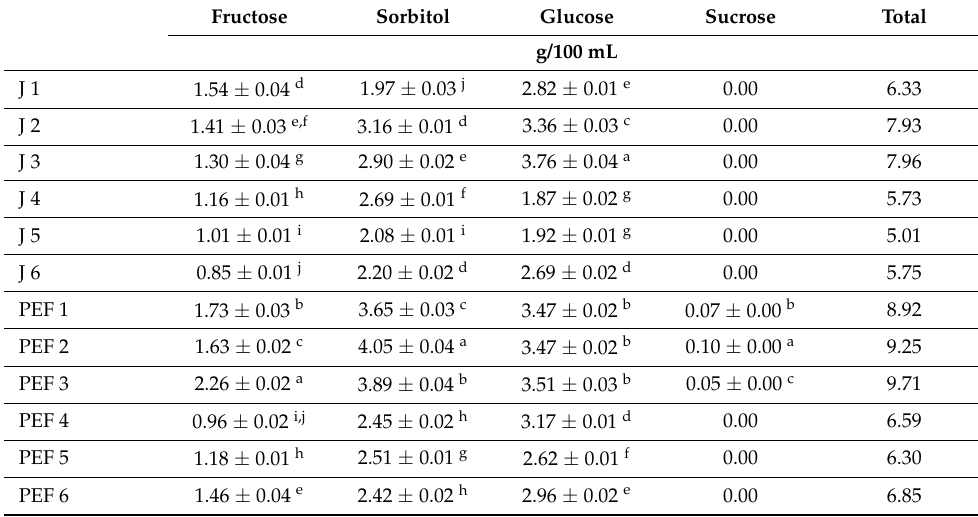
Table 3. Sugar content in black chokeberry juice.